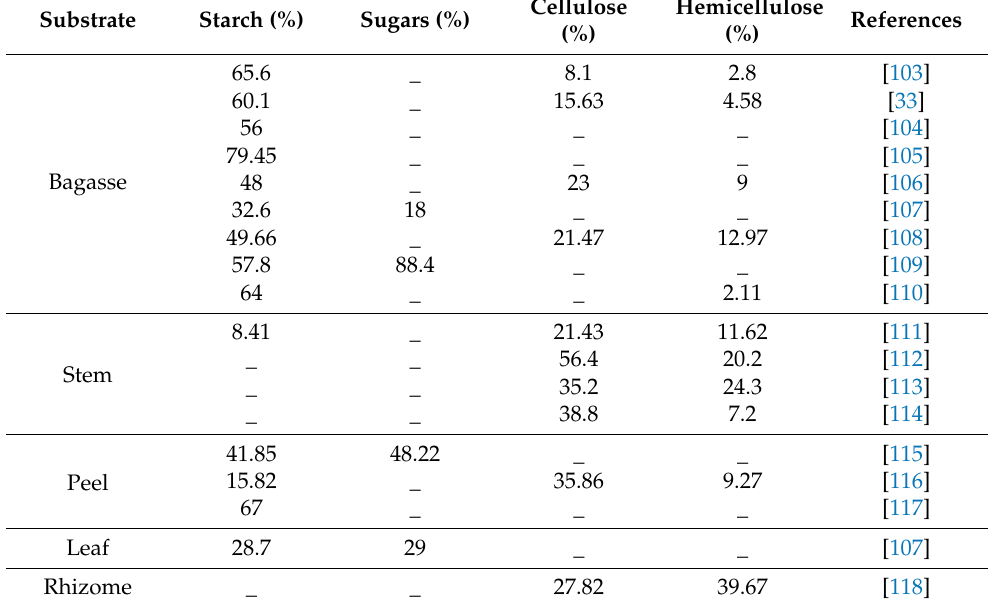
Table 3. Biochemical compositions of cassava-based